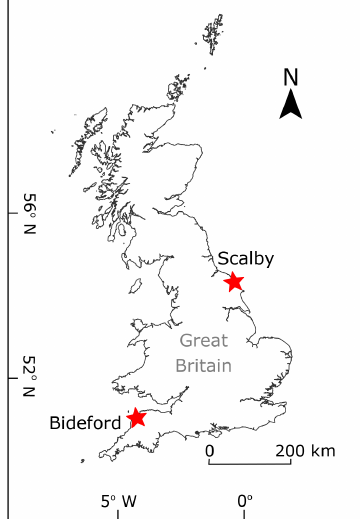
Figure 1. Map of Great Britain with two rock coast sites labelled. Bideford is located in south-west England on the north coast of De- von. Scalby is located on the east coast of England in north York-